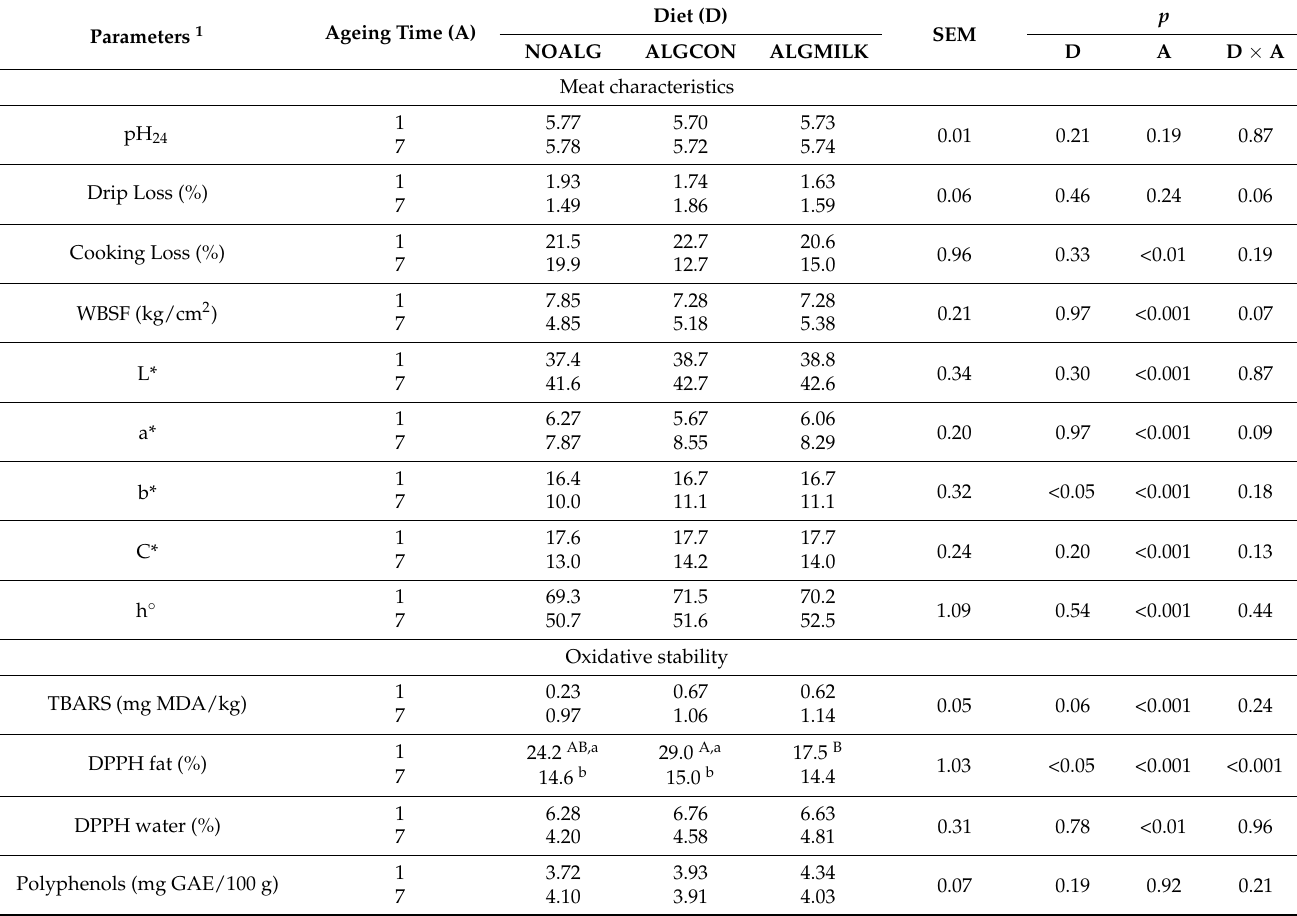
Table 2. Quality characteristics and oxidative stability of meat samples from feedlot lambs fed a conventional diet alone (NOALG) or from feedlot lambs with competent reticular groove reflex fed the same diet supplemented with 2.5% of algae meal, either mixed in the concentrate (ALGCON) or in the milk replacer (ALGMILK). Parameters